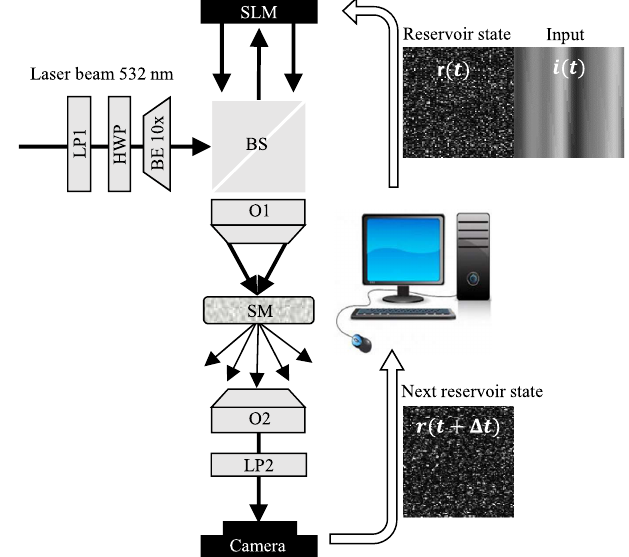
FIG. 2. Experimental setup to perform an optical reservoir computing. The SLM receives from the computer the consequent input i ð t Þ concatenated with the reservoir state r ð t Þ and imprints it into the spatial phase profile of the reflected beam (see the upper inset as a typical example). The scattering medium (SM) provides a complex linear mixing of the whole encoded information. Finally, the camera performs a nonlinear readout for the next reservoir state r ð t þ Δ t Þ (see the lower inset as a typical example), which is sent by the computer back to the SLM to be displayed with new input, and the process repeats. LP1 and LP2, linear polarizers; HWP, half-wave plate; BE, beam expander; BS, beam splitter; O1 and O2,